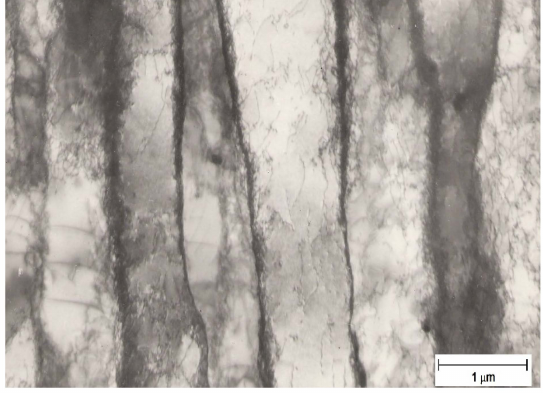
Figure 18. Dislocations in bainitic matrix.